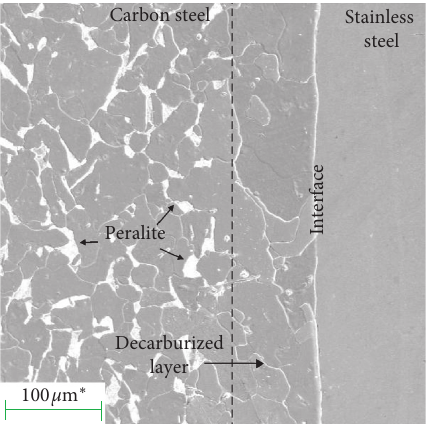
Figure 5: The microstructure in the thickness direction of the carbon steel (substrate) in the bimetal